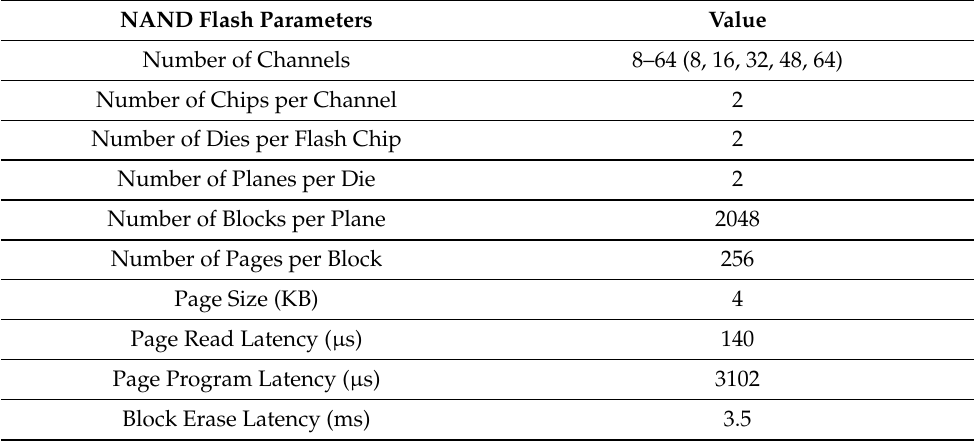
Table 2. Configuration of the simulated SSD.